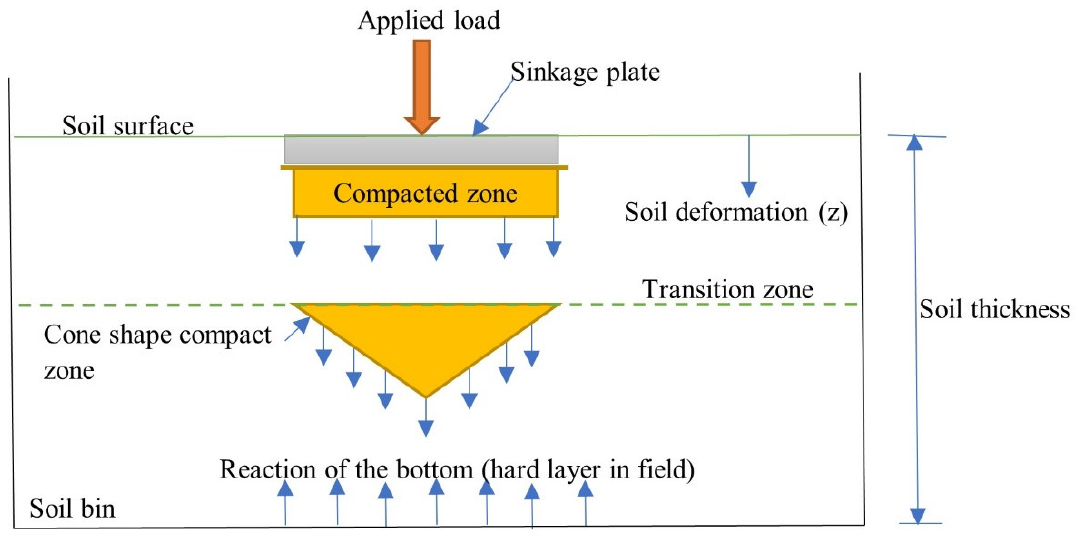
Figure 2. Schematic of the plate sinkage test.